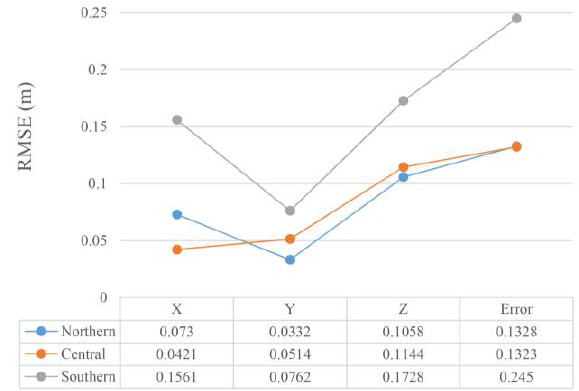
Table 3. RMSE trend on GCPs according to the spatial distribution on the site areas.